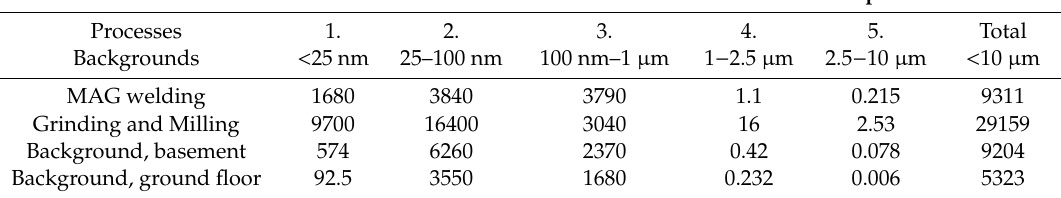
Table 1. Total number concentrations of five PM fractions (nano to 10 µ m) per cm 3 measured by on-line monitoring (SMPS and APS) during the shift related to the individual working processes including